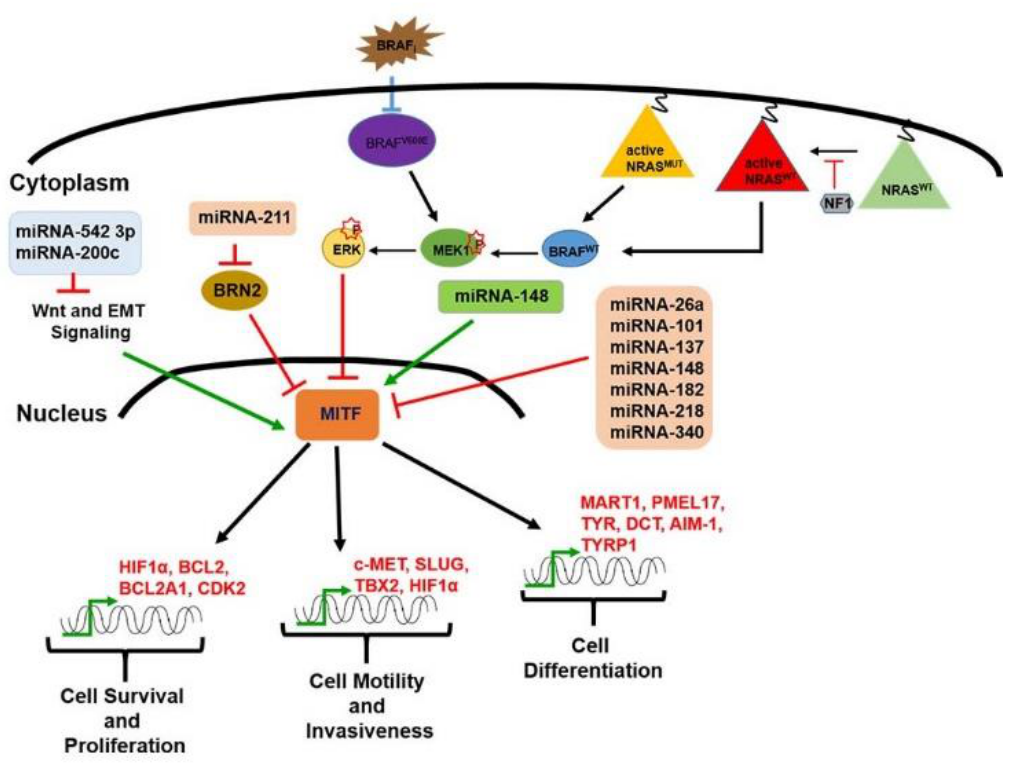
Figure 3. Schematic representation of several miRNAs able to regulate MITF, a master regulator of melanocyte development and of melanomagenesis.